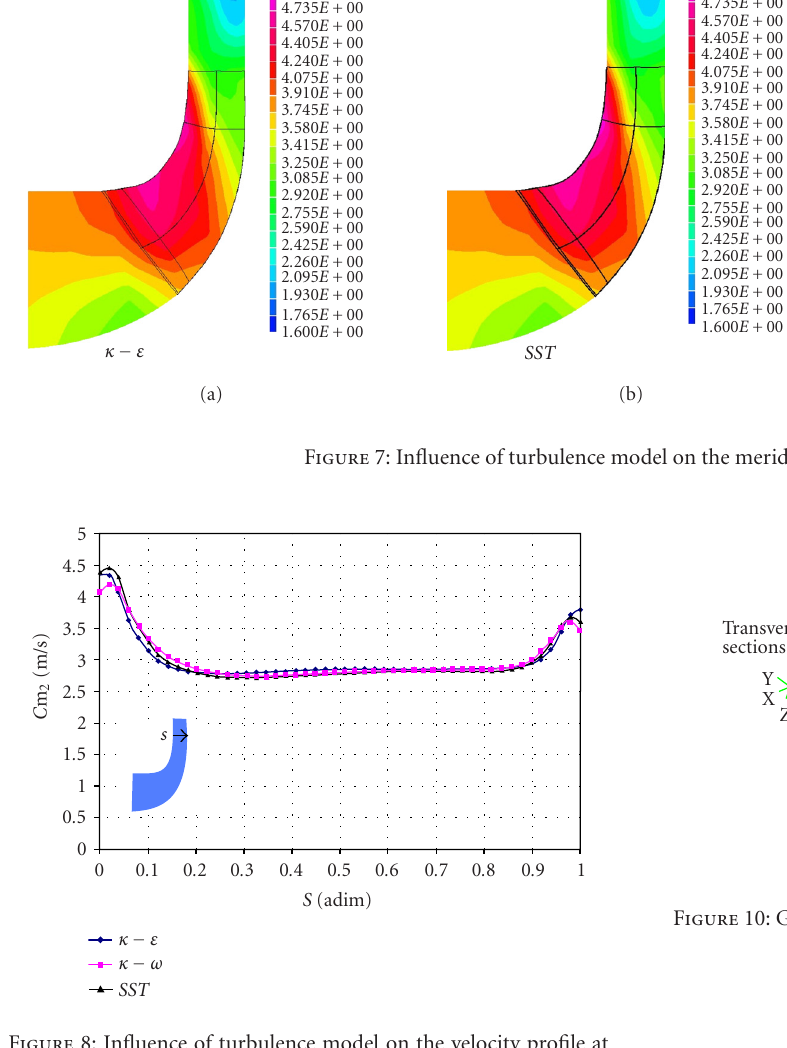
Figure 8: Influence of turbulence model on the velocity profile at the trailing of the blade.